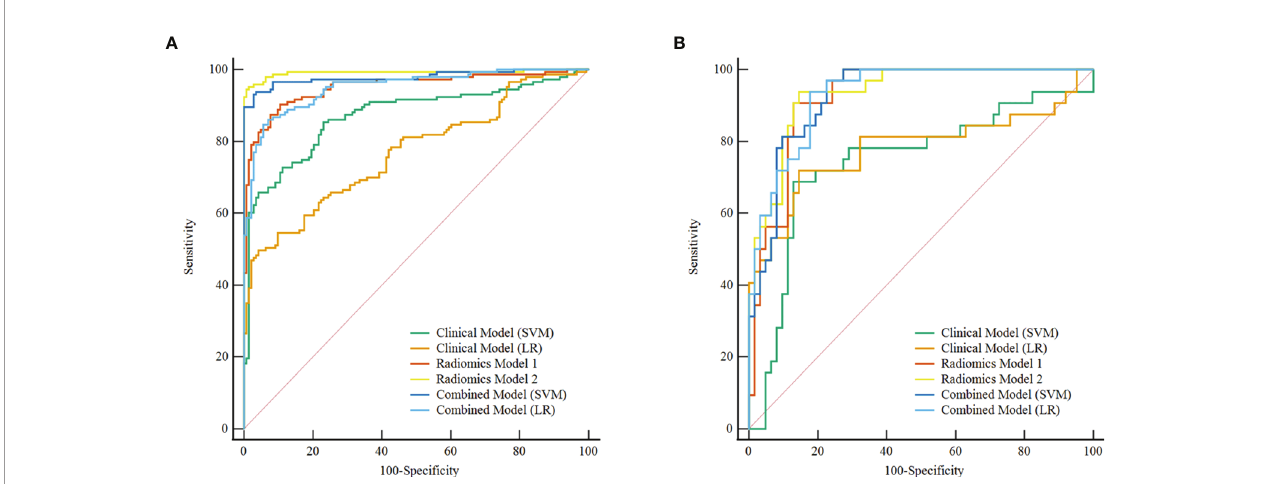
FIGURE 5 | Comparison of ROC curve between different models in the training set (A) and test set (B) . ROC, receiver operating characteristic; SVM, support vector machine; LR, logistic regression. Radiomics model 1, the best radiomics model based on a single phase (arterial-LASSO-SVM); Radiomics model 2, the best radiomics model based on a multiphasic phase